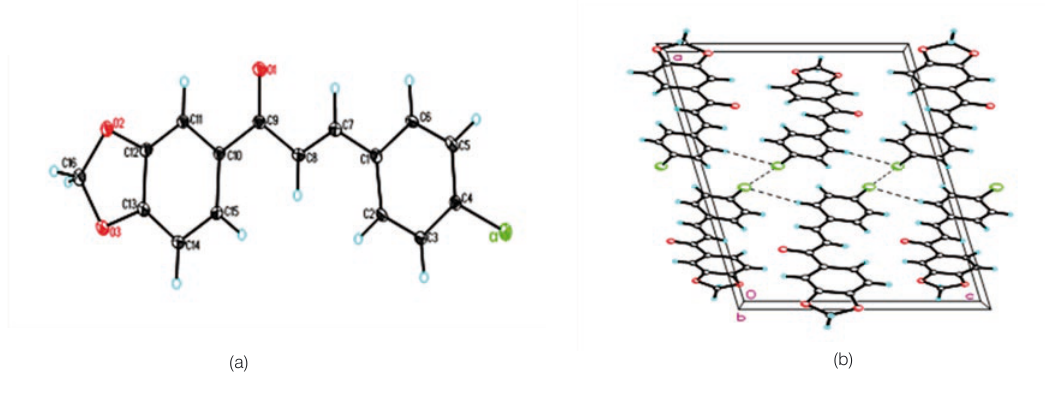
Figure 1. Ortep drawings (a) and molecular packing (b) for (2E)-1-(1,3-benzodioxol-5-yl)-3-(4- chlorophenyl)prop-2-en-1-one